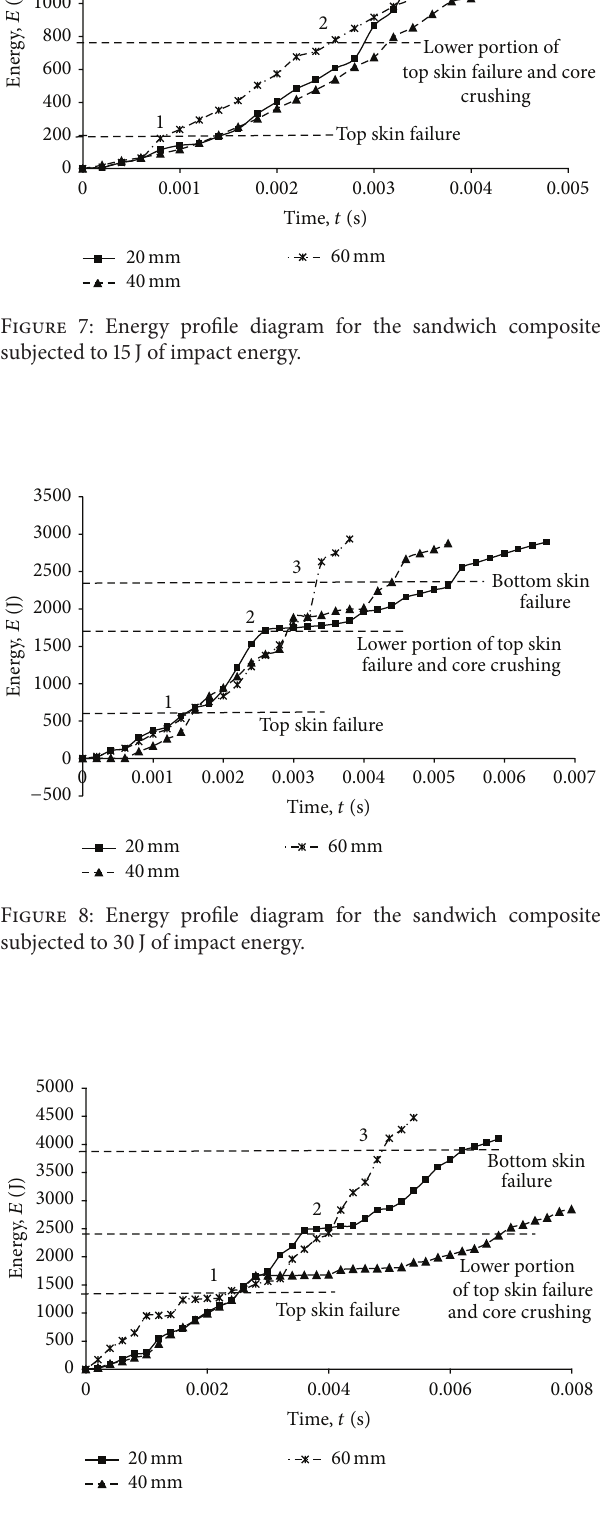
Figure 9: Energy profile diagram for the sandwich composite subjected to 45 J of impact energy.